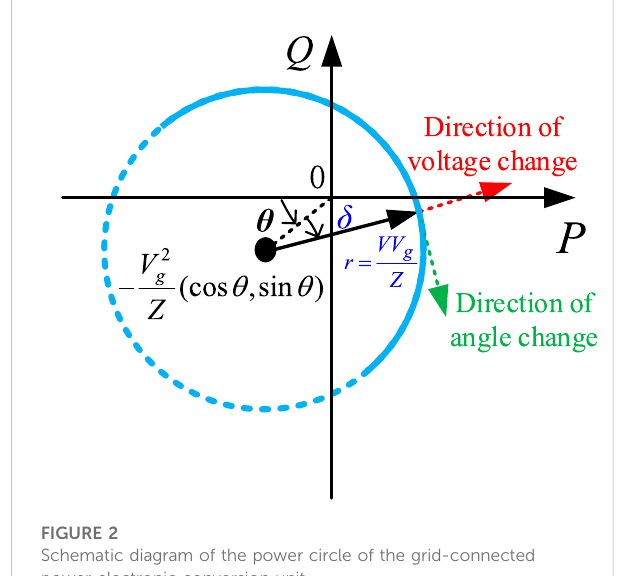
FIGURE 2 Schematic diagram of the power circle of the grid-connected power electronic conversion